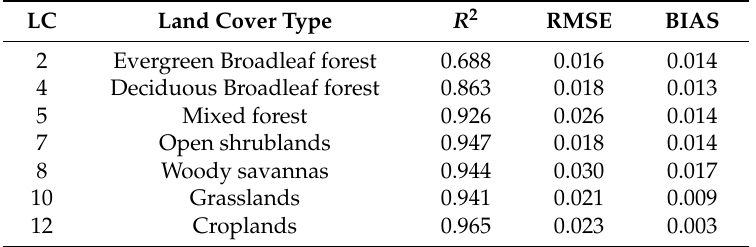
Table 4. Comparison in terms of accuracy between TM and MODIS for different land types.